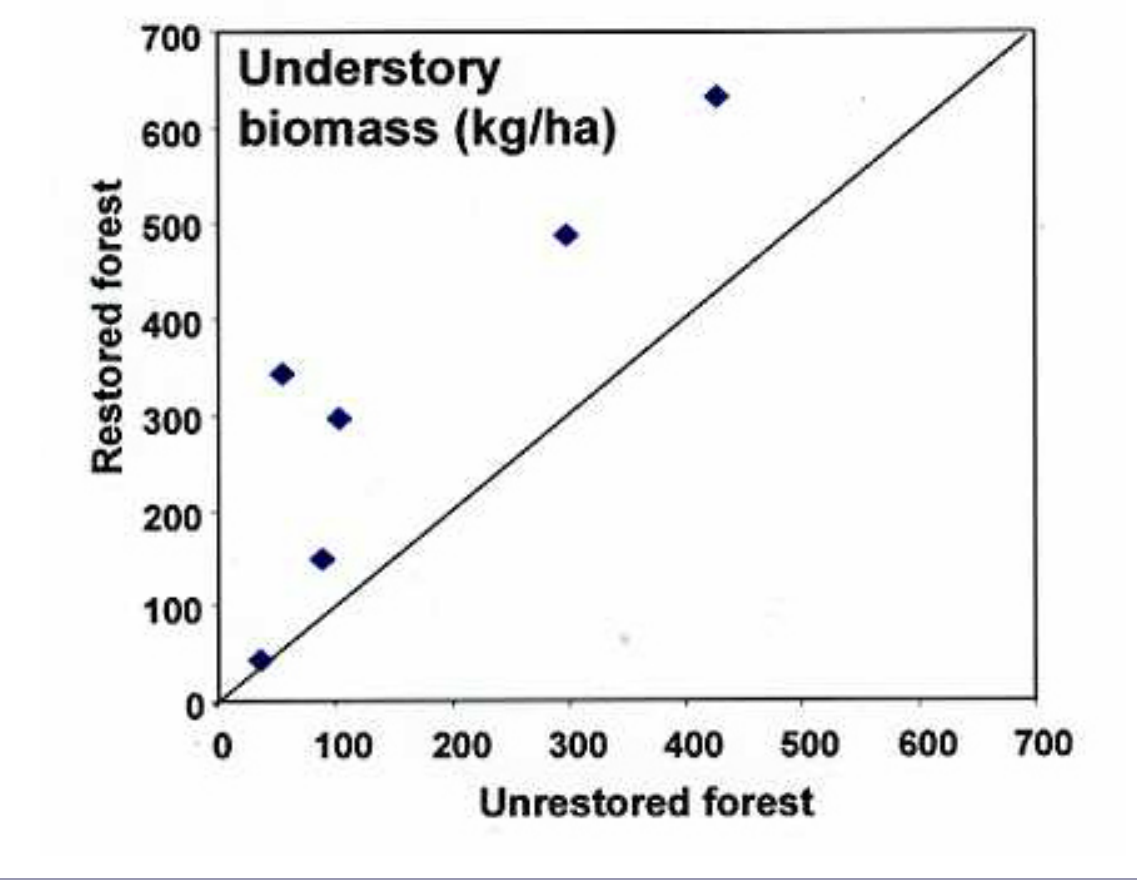
Fig. 3. Understory biomass and growth were much higher in forests with restoration treatments than in control forests (from summary of Abella 2004, Gildar et al. 2004, Moore et al. 2006). The greatest proportional increases occur when the biomass in the unrestored forests is particularly